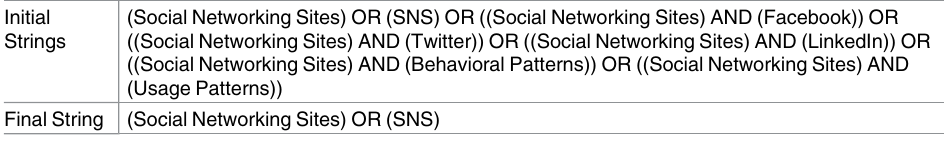
Table 1. Search Strings. Initial (Social Networking Sites) OR (SNS) OR ((Social Networking Sites) AND (Facebook)) OR Strings ((Social Networking Sites) AND (Twitter)) OR ((Social Networking Sites) AND (LinkedIn)) OR ((Social Networking Sites) AND (Behavioral Patterns)) OR ((Social Networking Sites) AND (Usage Patterns)) Final String (Social Networking Sites) OR